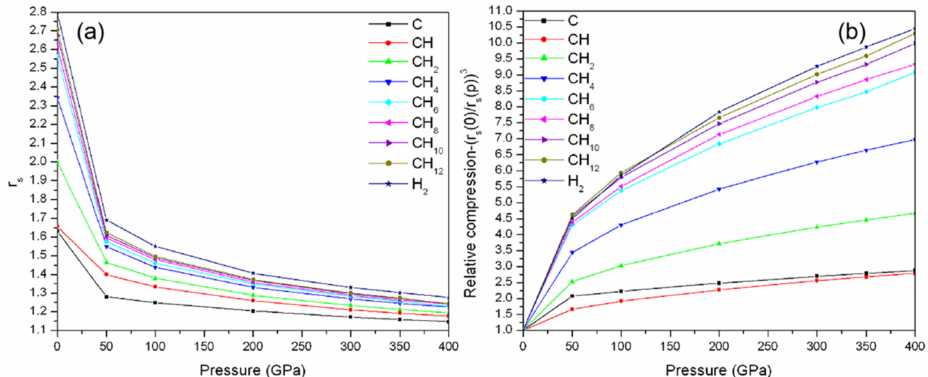
Figure 2. ( a ) Wigner–Seitz radius (r s ) of carbon, H 2 , and CH n structures (n = 1, 2, 4, 6, 8, 10, and 12) as a function of pressure. ( b ) Computed relative compression as a function of pressure. The relative compression is defined by and r s (p) is the Wigner–Seitz radius at ambient pressure and certain high pressure, respectively.